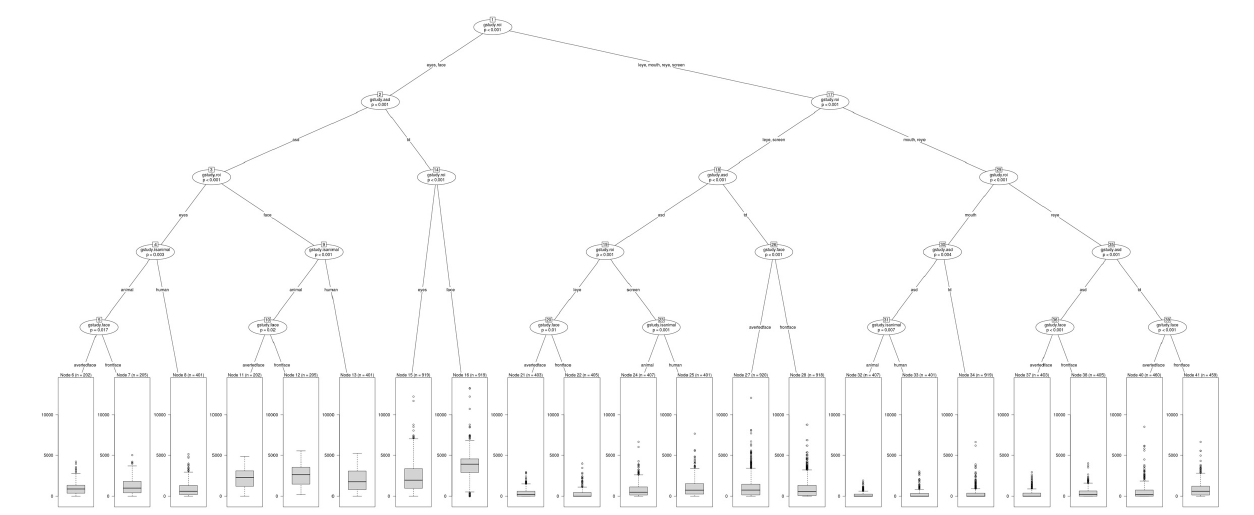
FIGURE 2 | Conditional Inference Tree showing statistically significant interactions of the independent variables.